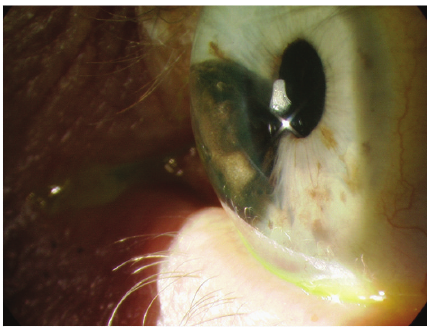
Figure 1: Large iris melanoma occupying a significant percentage of the anterior chamber with associated